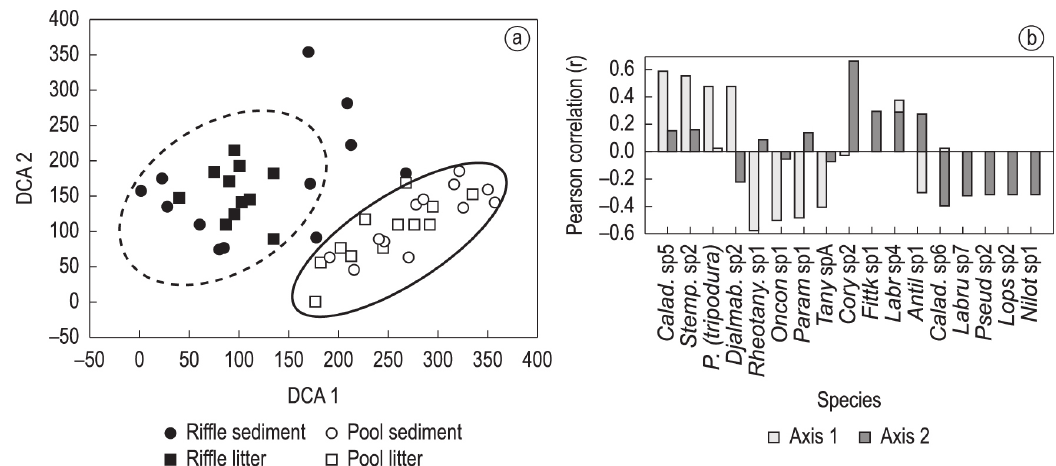
Figure 6. Scores ordination of the axes 1 and 2 of DCA per microhabitats sampled (a) and Pearson correlation between the most significant taxa with the scores of the axes 1 and 2 of DCA (b). Calad. Sp5: Caladomyia sp.5; Stemp.sp2: Stempellinela sp.2; P.(Tripodura) : Polypedilum ( Tripodura ); Djalmab sp2: Djalmabatista sp.2; Rheotany. sp1: Rheotanytarsus sp1; Oncon sp1: Onconeura ; Param sp1: Parametriocnemus sp.1: Tany spA: Tanytarsini sp.A; Cory sp2: Corynoneura sp.2; Fittk sp1: Fittkauimyia sp.1; Labr sp4: Labrundinia sp.4; Antil sp1: Antillocladius sp.1; Calad. sp6: Caladomyia sp.6; Labrun sp7: Labrundinia sp.7; Pseud sp2: Pseudochironomus sp. 2; Lops sp2: Lopescladius sp . 2; Nilot sp1: Nilotanypus